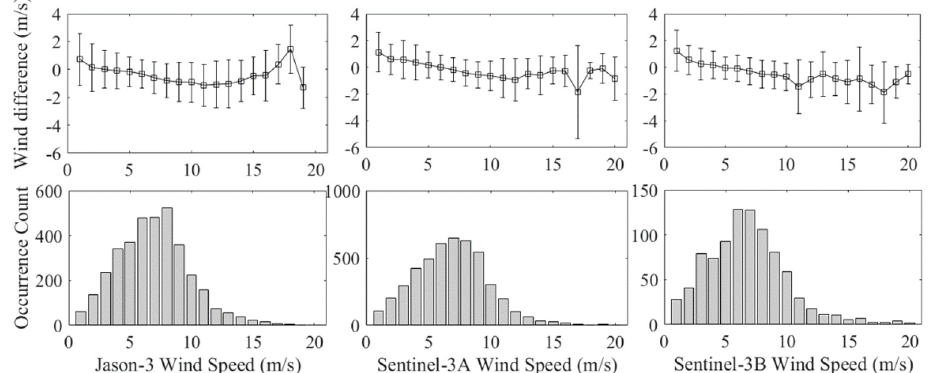
Sentinel-3B WS data to be determined.